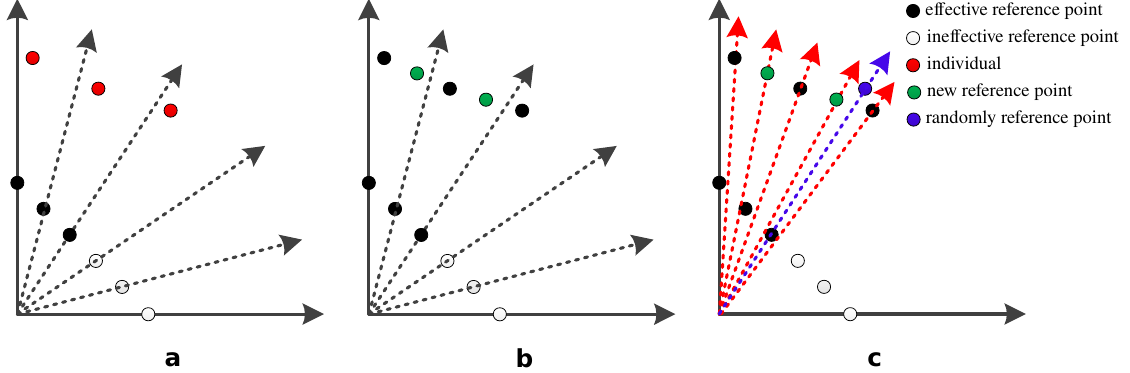
Figure 3. An Example of reference points learning population. ( a ) Start state. ( b ) Intermediate state. ( c ) End